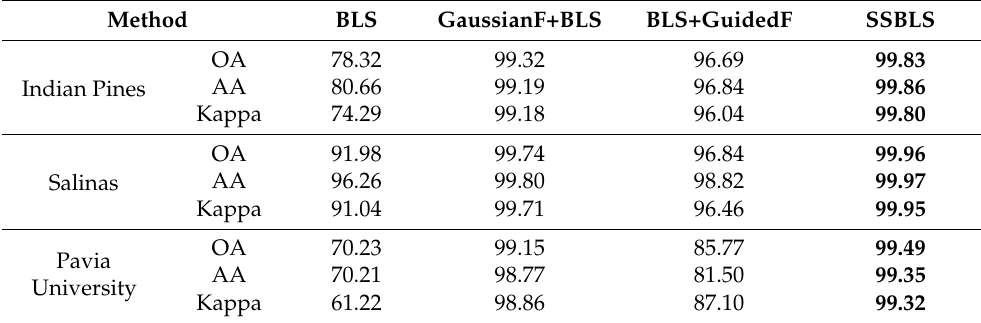
Table 2. The results of ablation experiments on the three datasets in term of overall accuracy, OA (%), average accuracy, AA (%), and kappa coefficient, Kappa